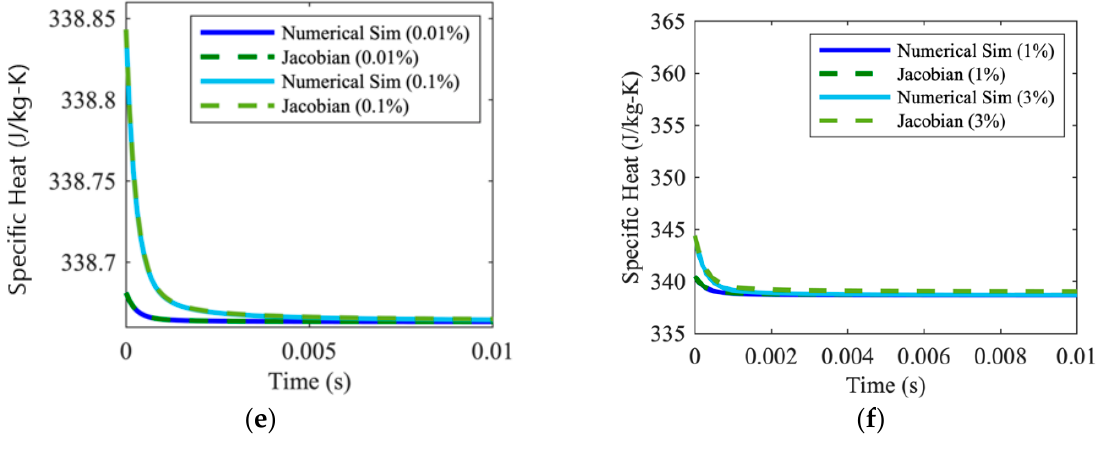
Figure 3. Thermophysical property evolutions at the point of the temperature perturbation. ( a ) Thermal conductivity evolution for temperature perturbations of 0.01 and 0.1% T initial . ( b ) Thermal conductivity evolution for temperature perturbations of 1 and 3% T initial . ( c ) Density evolution for temperature perturbations of 0.1 and 0.01% T initial . ( d ) Density evolution for temperature perturbations of 1 and 3% T ini . ( e ) Specific heat evolution for temperature perturbations of 0.1 and 0.01% T initial . ( f ) Specific heat evolution for temperature perturbations of 1 and 3% T initial .